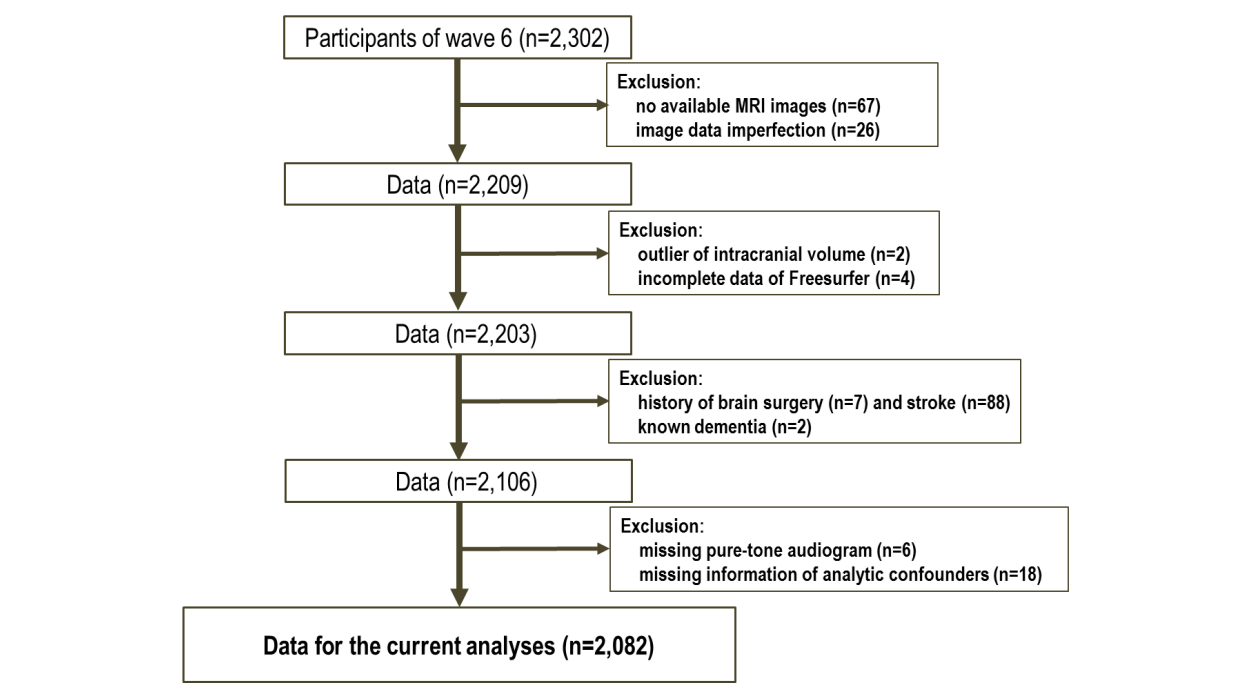
FIGURE 1 | Flow chart of subject